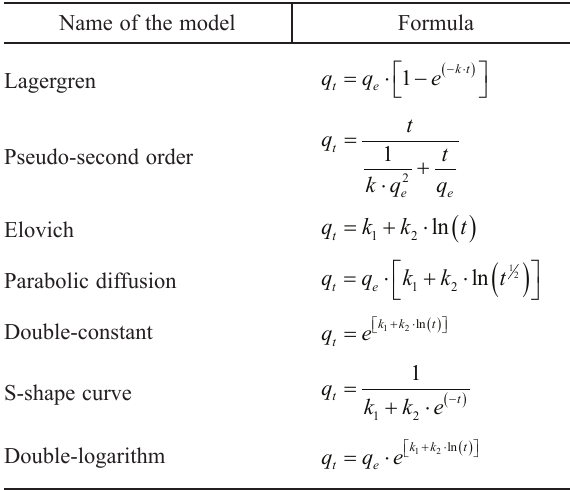
Table 2 – Kinetics models proposed for the heavy metal sorption on solid materials Name of the model